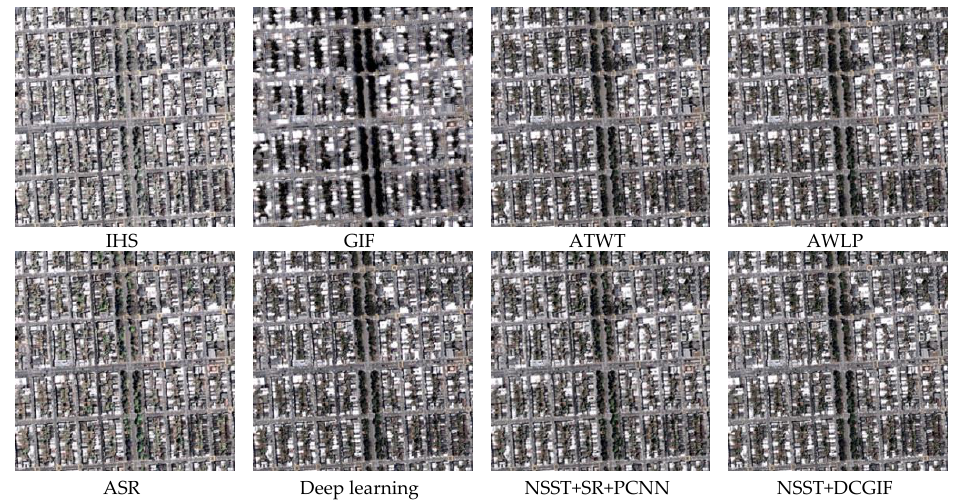
Figure 15. Real Data comparison experiment results. Table 5. Objective evaluation of real data.